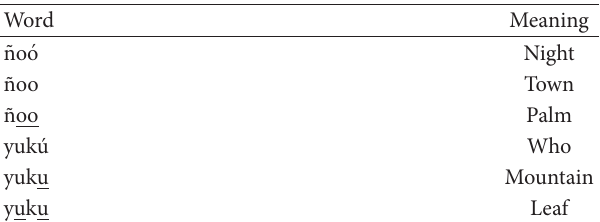
Table 1: Examples of Mixtec words with